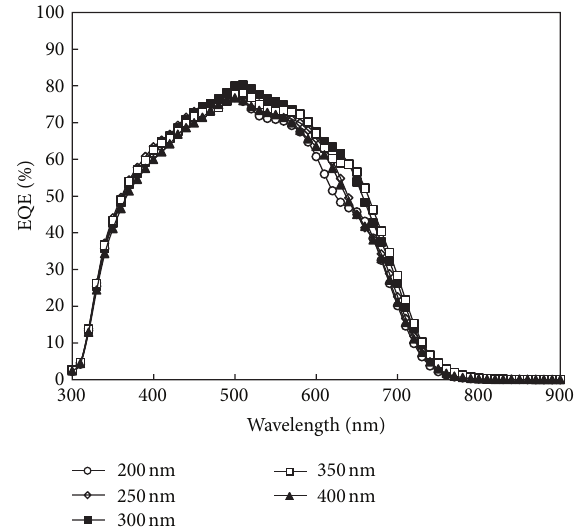
Figure 2: Experimental quantum efficiencies of a-Si:H-like solar cells with different i-layer